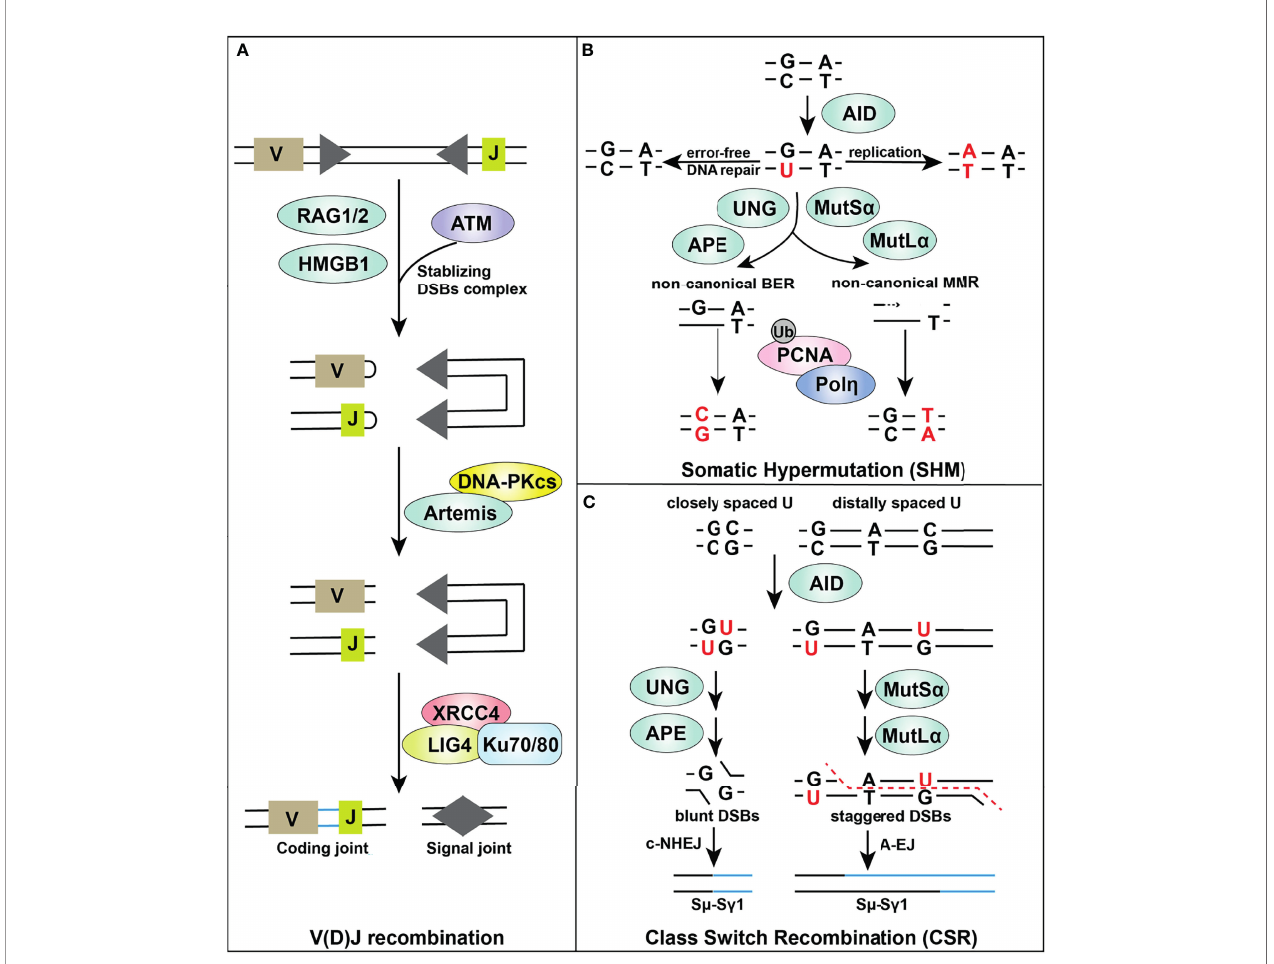
FIGURE 2 | Overview of DDR components in adaptive immune responses. Certain DDR signaling pathways, such as MMR, BER, NHEJ, and A-EJ, are required in V(D)J recombination (A) , SHM (B) and CSR (C) processes, supporting successful lymphocyte